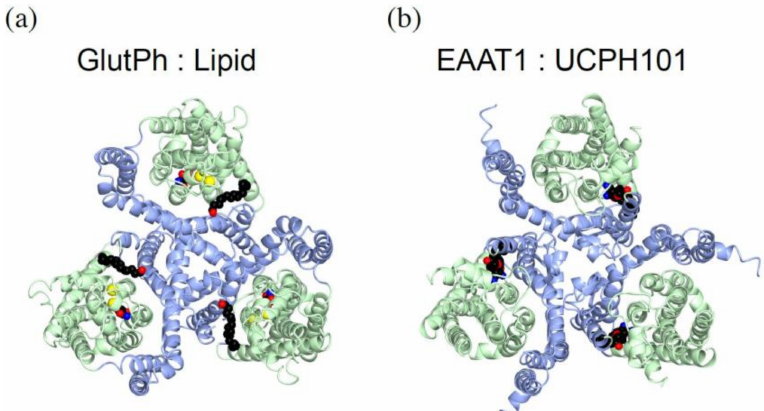
Figure 4. Glutamate transporter inhibitors bound at the domain interface. The trimerization domain is in light blue, and the transport domain is in light green with L-aspartate (spheres) and a sodium ion (yellow). ( a ) GluTPh with a lipid or detergent molecule (spheres, red/black) between domain